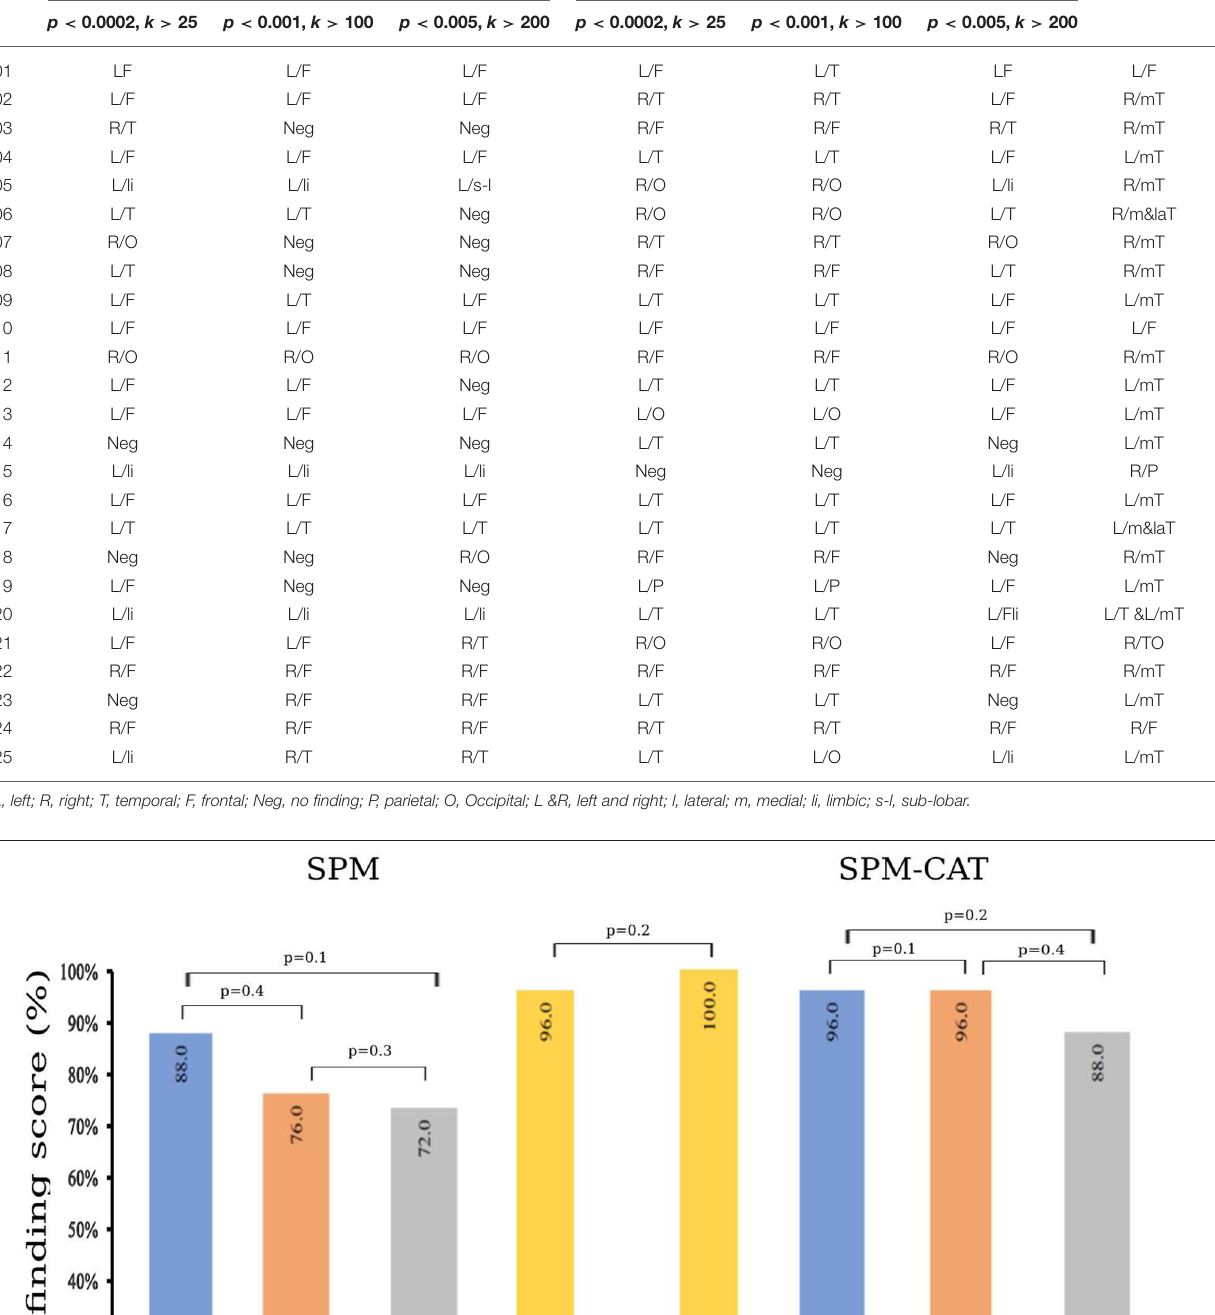
TABLE 4 | Comparison between clusters with a significant difference in FDG-PET images and confirmed EZ according to postsurgical follow-up. No. SPM SPM-CAT EZ Engel p < 0.0002, k > 25